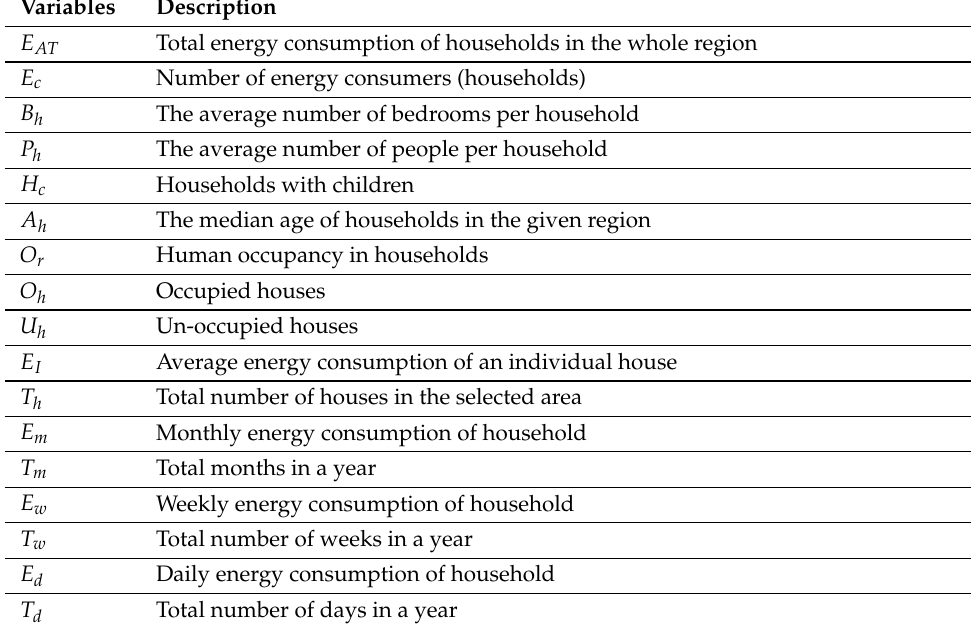
Table 3. Notations